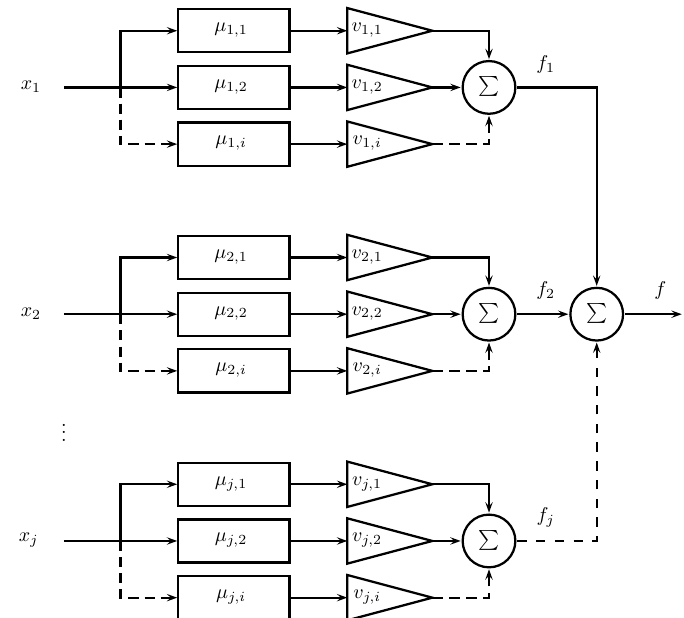
Figure 11. General diagram of a compact system with architecture II.